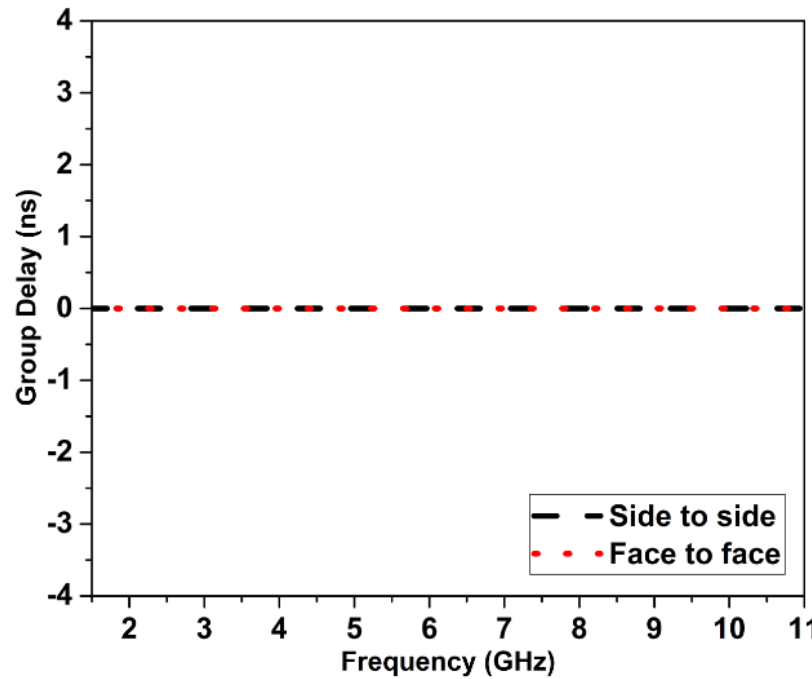
Figure 14. Group delay proposed UWB antenna.